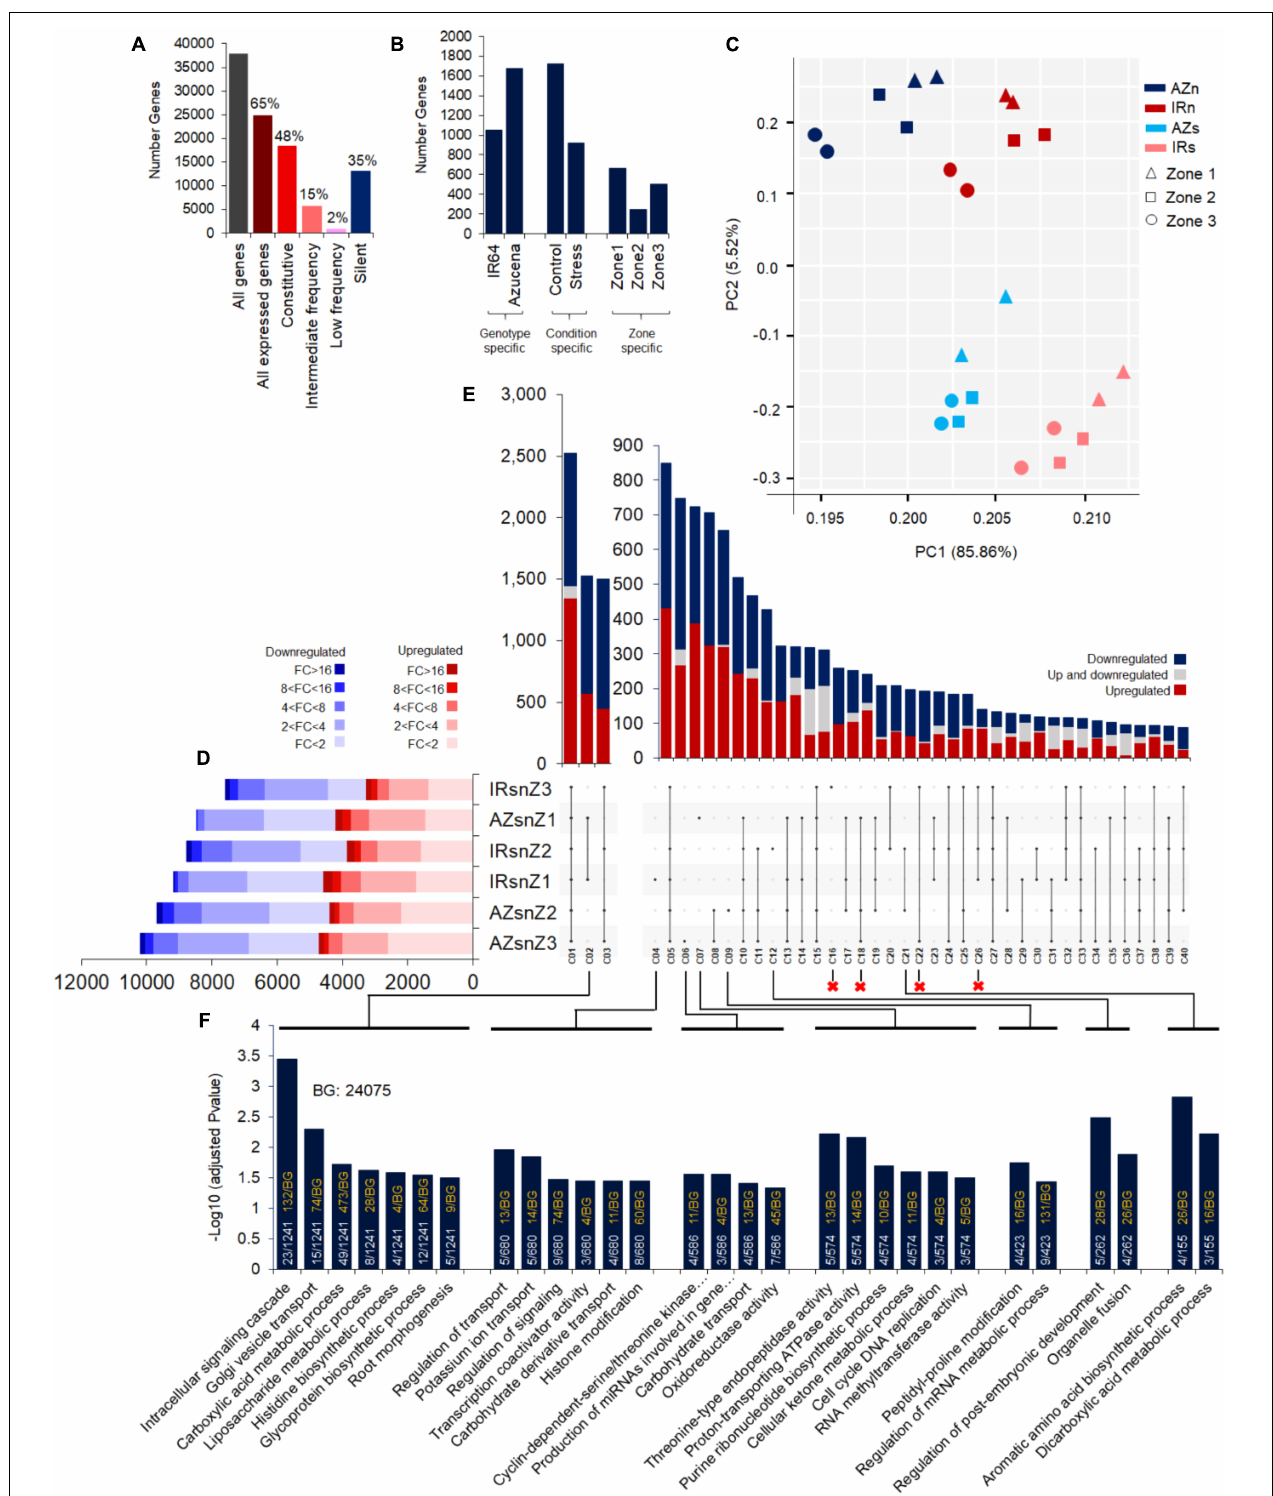
FIGURE 3 | Transcriptome profiling of Azucena and IR64 root zones under control and water stress conditions and the intersections of DEGs across 6 interaction of genotypes, zones and conditions. (A) The number of genes not expressed in any sample (the silent group) (FPKM < 1 in none of the doublet sets of replicates), expressed in less than 20% of samples (Low frequency), expressed in 20–80% of samples (Intermediate frequency), and expressed in more than 80% of samples